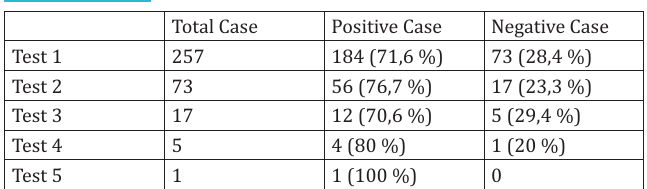
Descriptive Statistics of the RT-PCR